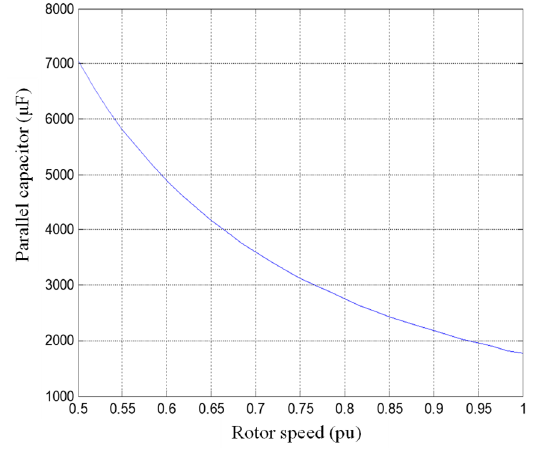
Figure 8. C p variation.